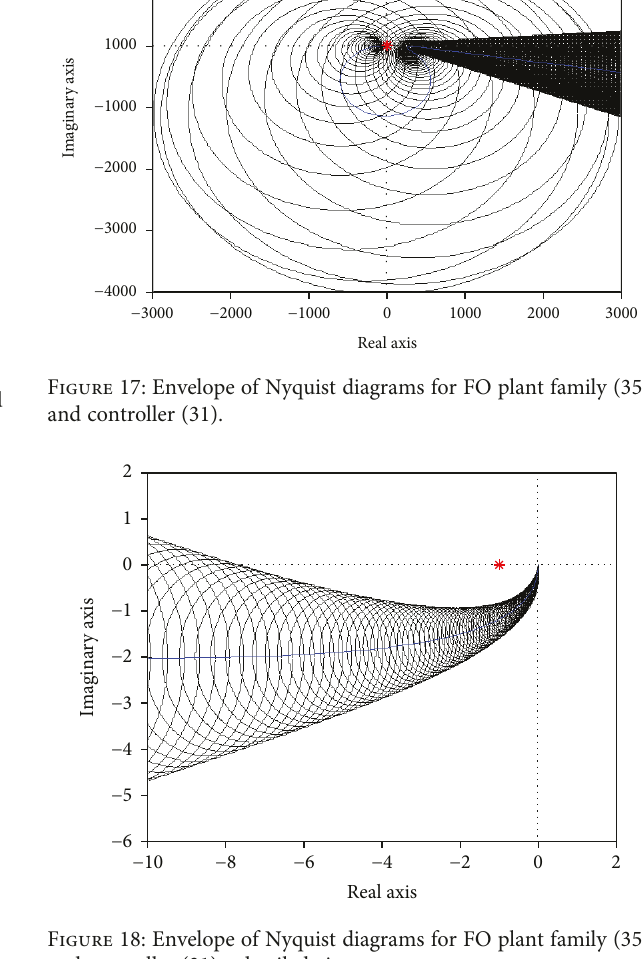
Figure 16: Zoomed version of Bode magnitude plots from Figure 15 — set of FO normalized perturbations and weight function (34).